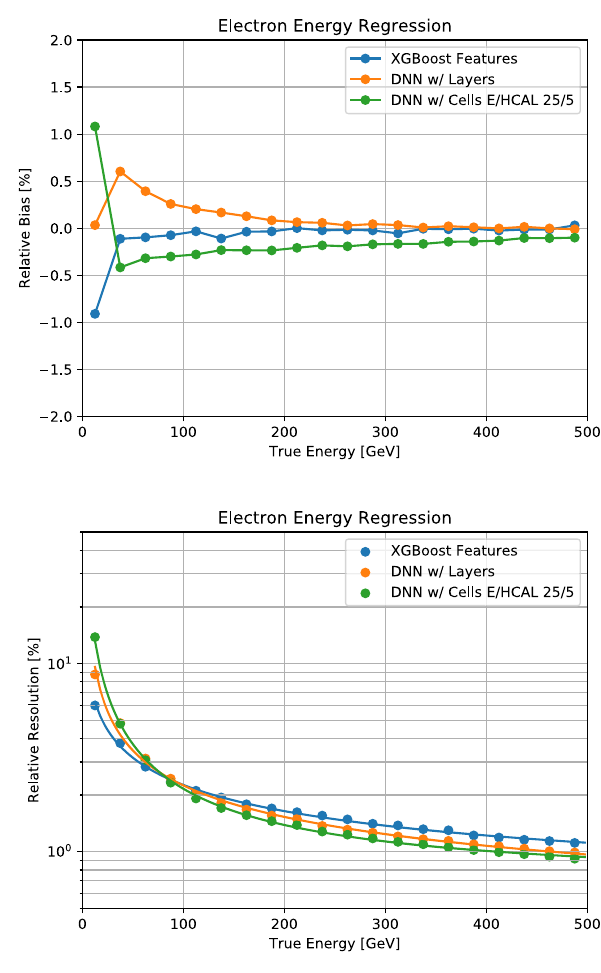
Fig. 33 Bias (top) and resolution (bottom) as a function of true energy for DNN energy predictions for electrons, using as input either the energy summed in layers of z , or the full cell information